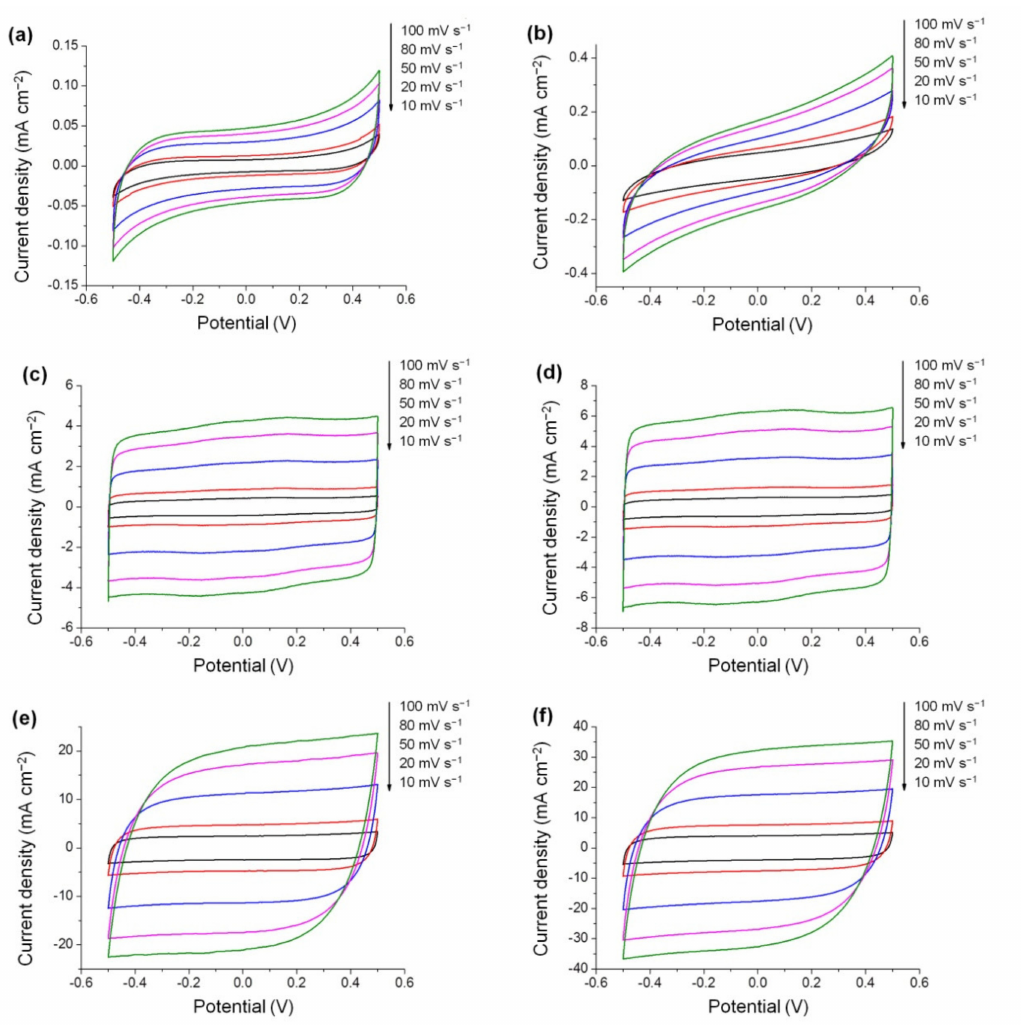
Figure 5. Cyclic voltammetry ( CV ) curves of symmetric supercapacitor cells assembled with GtPU ( a ), GnPU ( b ), 50 PEDOT/GtPU ( c ), 50 PEDOT/GnPU ( d ), 110 PEDOT/GtPU ( e ) and 110 PEDOT/GnPU sponge ( f ). CV curves were obtained with different scan rates from 10 to 100 mV s − 1